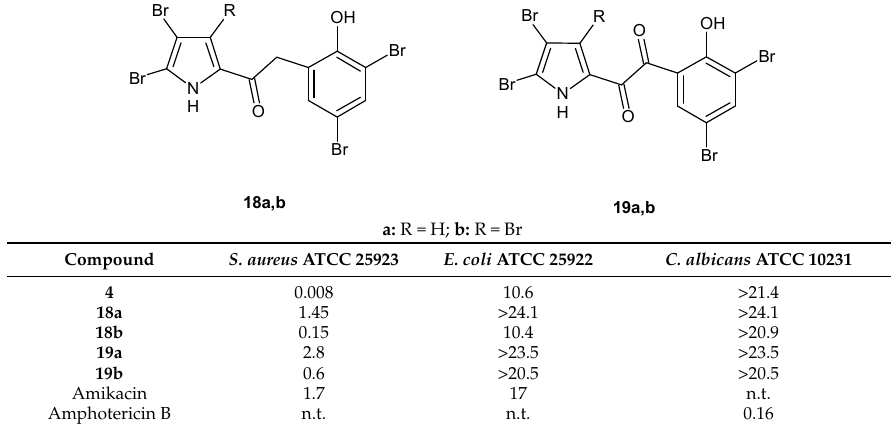
Table 8. Antimicrobial activity in vitro , MIC values expressed in μ M for all strains tested.